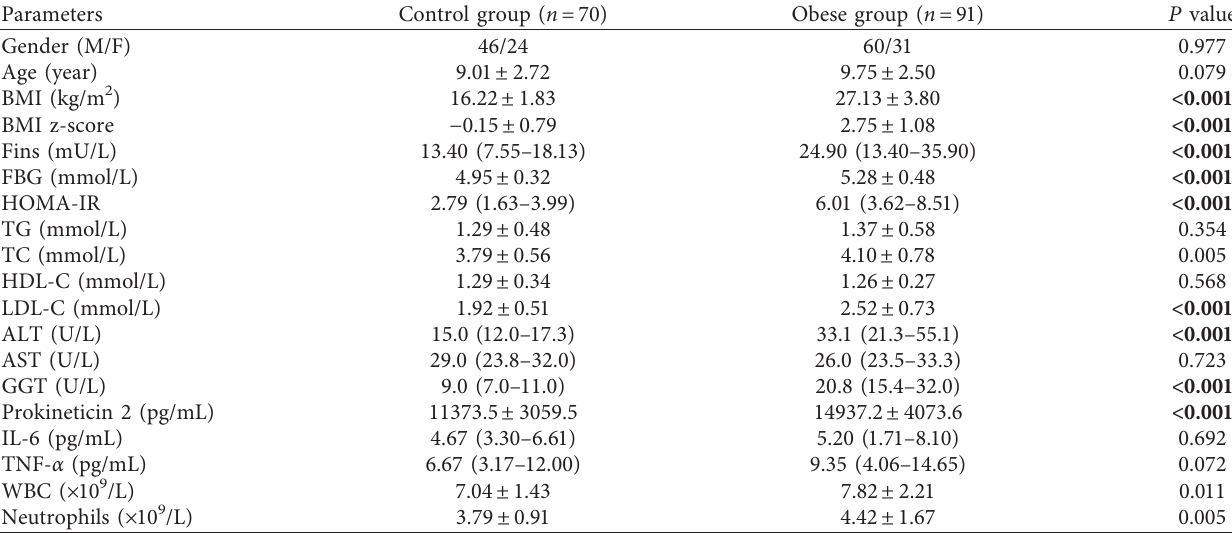
Table 1: Comparison of clinical and laboratory parameters between control group and obese group.